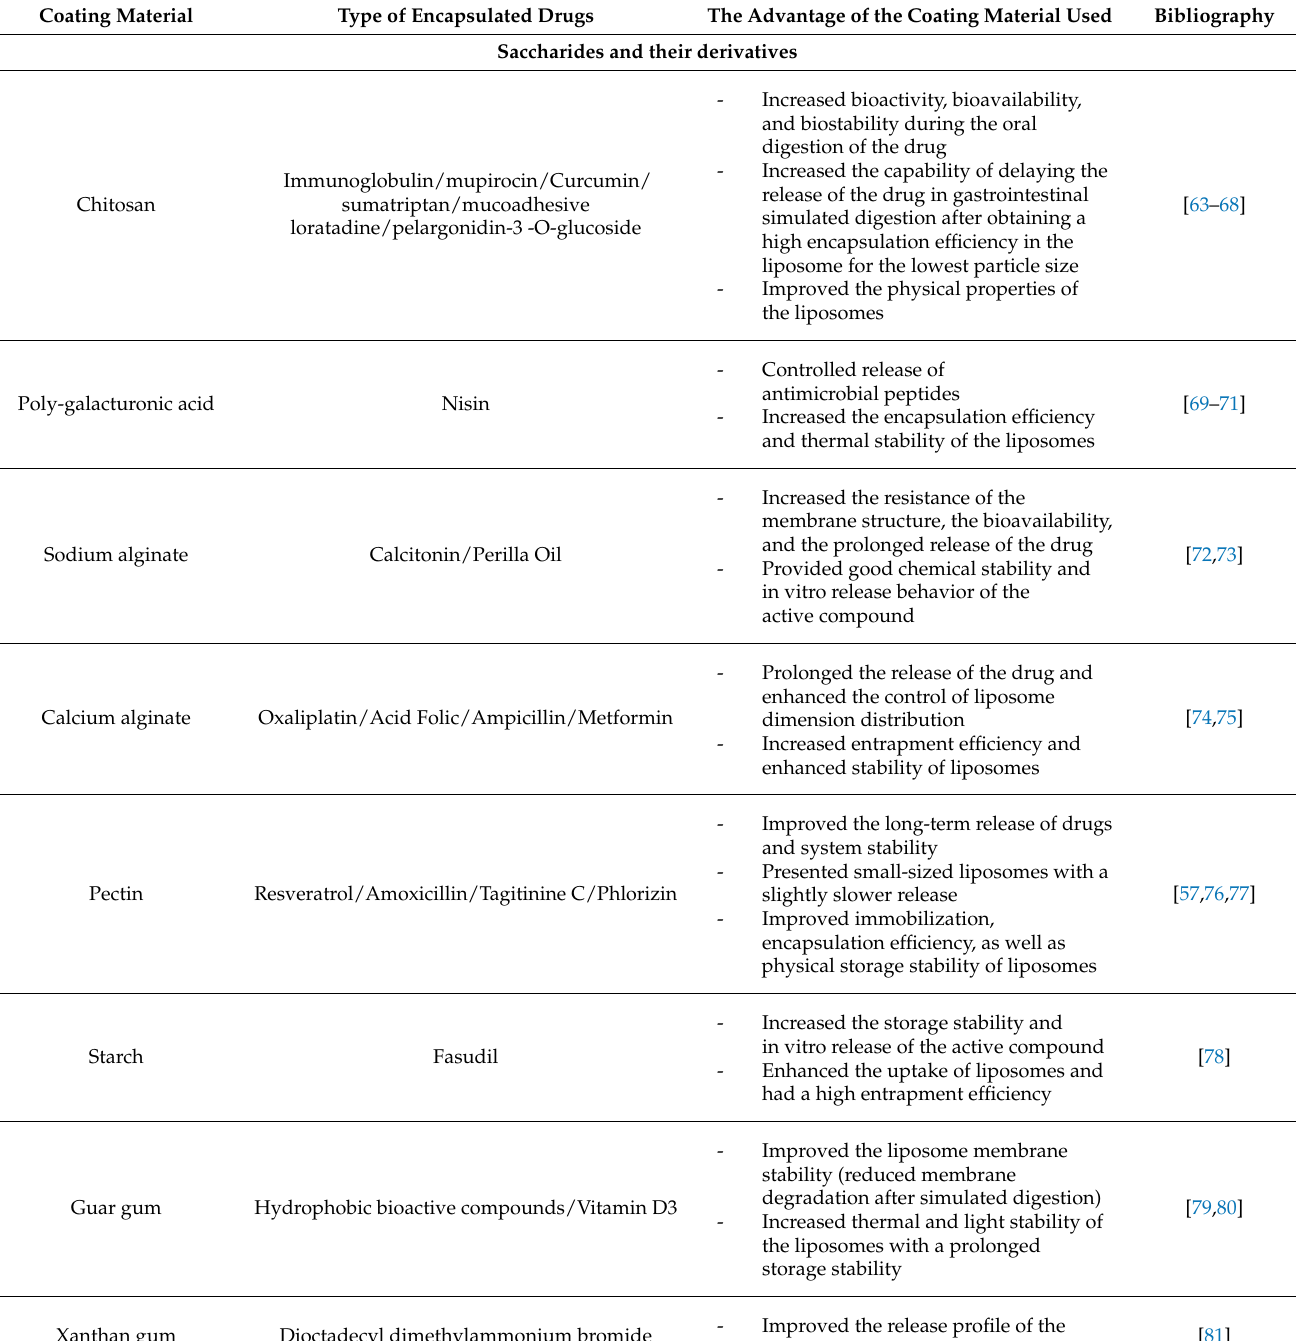
Table 3. Coating materials for liposomes as drug delivery